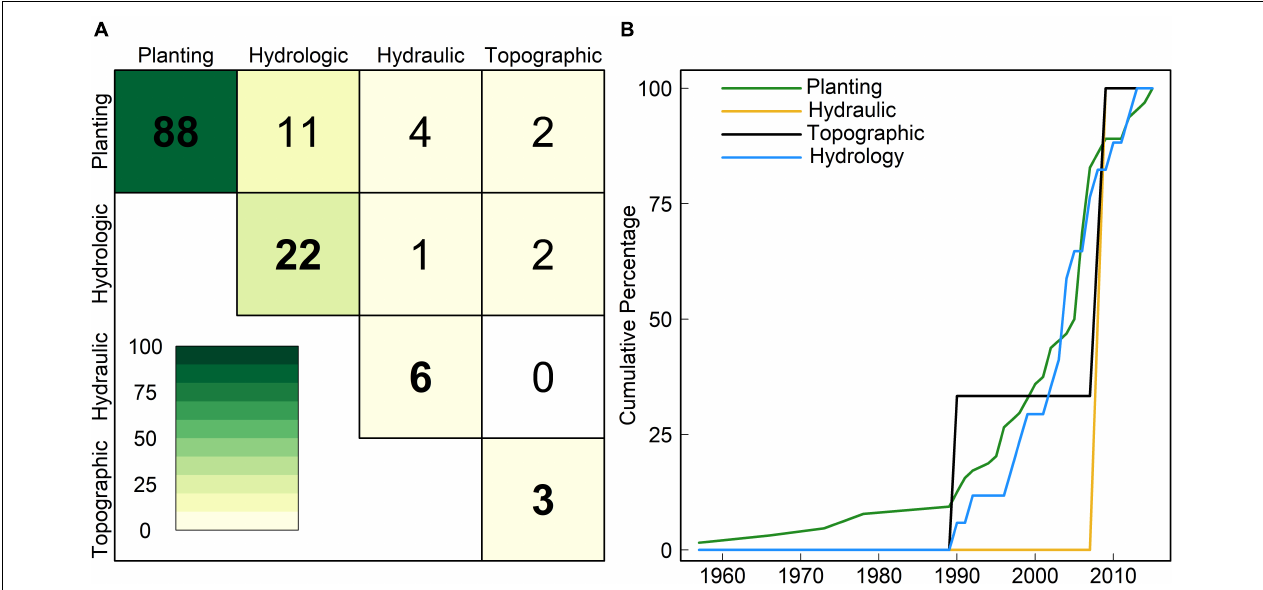
FIGURE 5 | (A) Frequency of different restoration methods used in the case studies. The diagonal boxes (bold numbers) identify the percentage of the different restorative methods used overall. The off-diagonal boxes represent the percentage of case studies that record information for the two interacting restorative methods. (B) The cumulative percentage of cases studies within each of the four intervention types vs. the start year of the